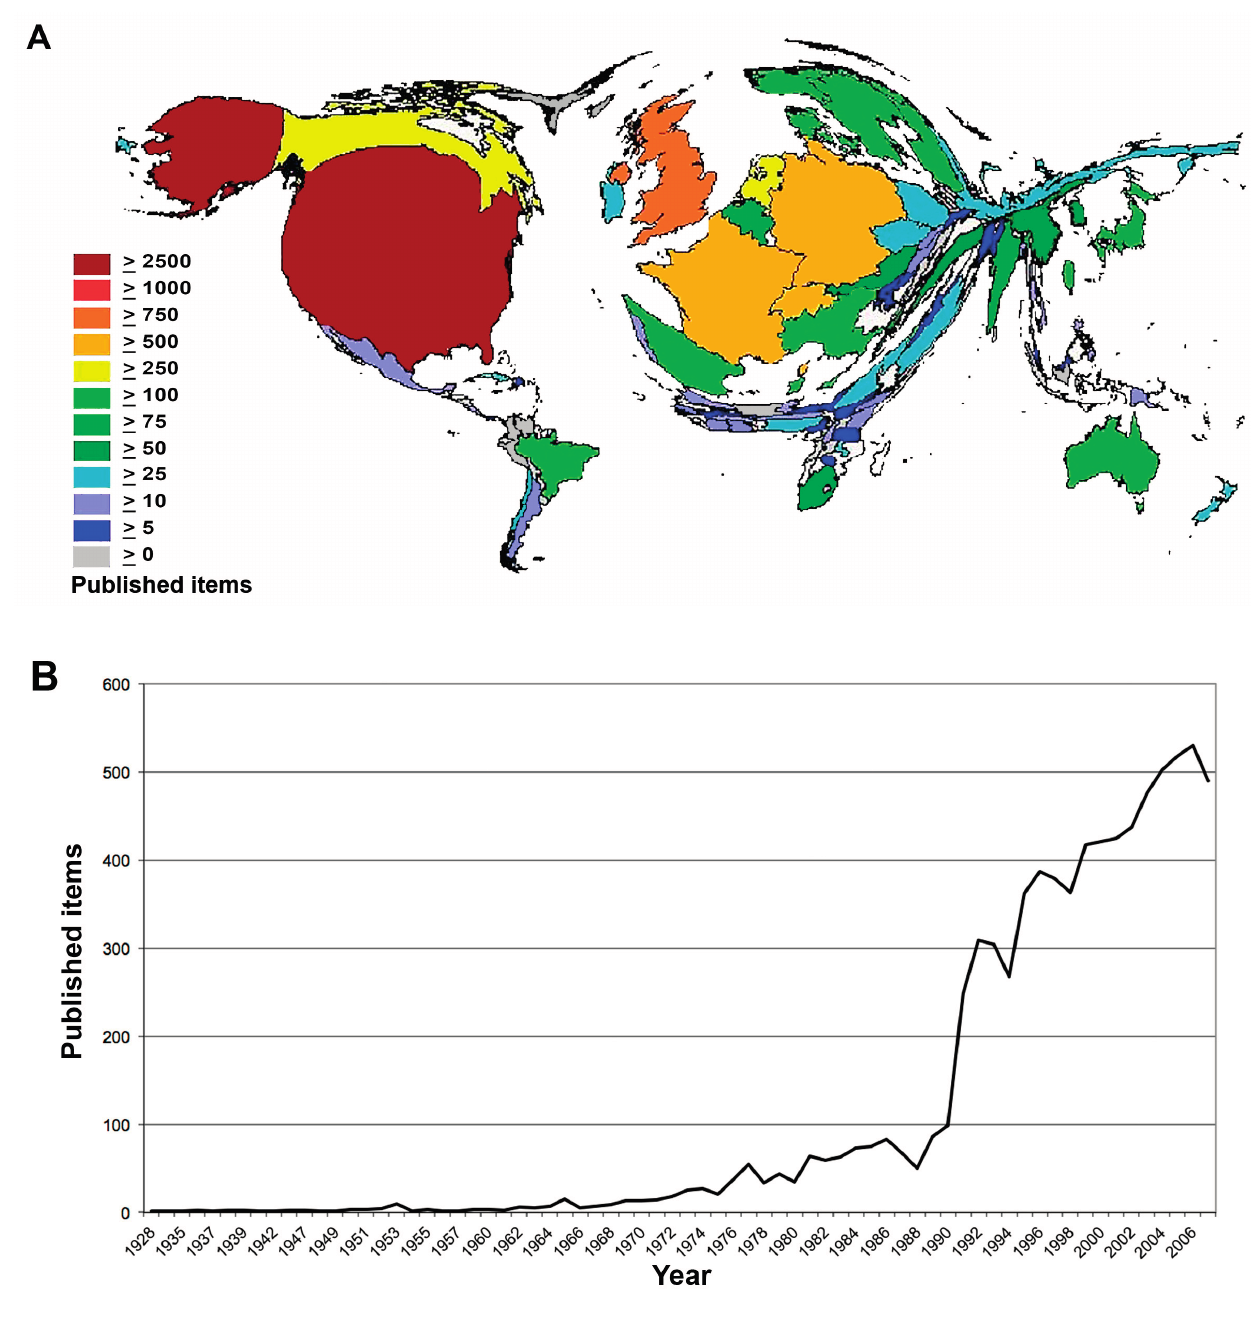
Figure 1. Global research activity. ( A ) Density-equalizing map of the numbers of published items. ( B ) Development of productivity over a time period of 79 years. In 1990, abstracts were included to the Web of Science